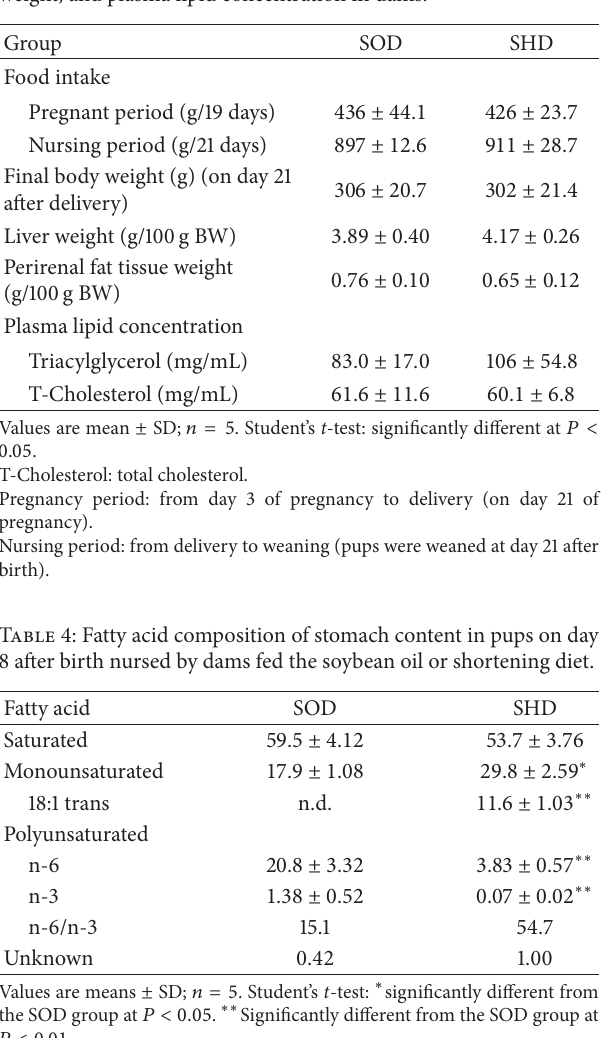
Table 3: Food intake, body weight, liver and perirenal fat tissue weight, and plasma lipid concentration in dams.